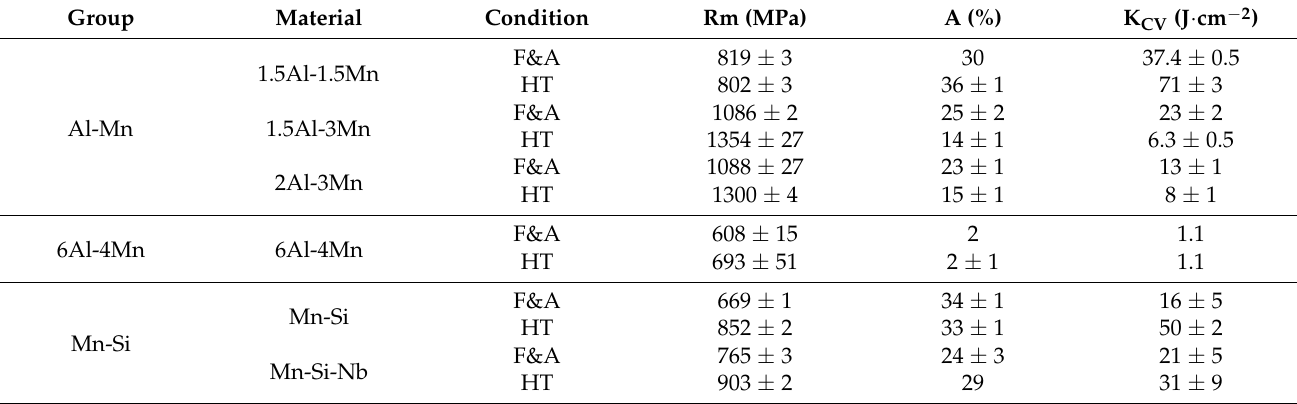
Table 7. Tensile strength, elongation and impact toughness—average results of three test repeats with standard deviation, F&A—forged and annealed, HT—heat treated.